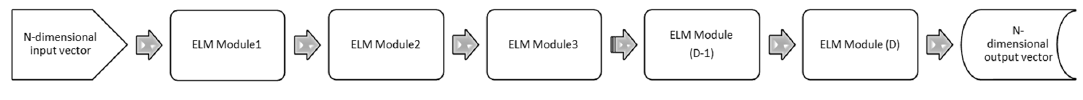
Figure 2. D-module deep ELM network.